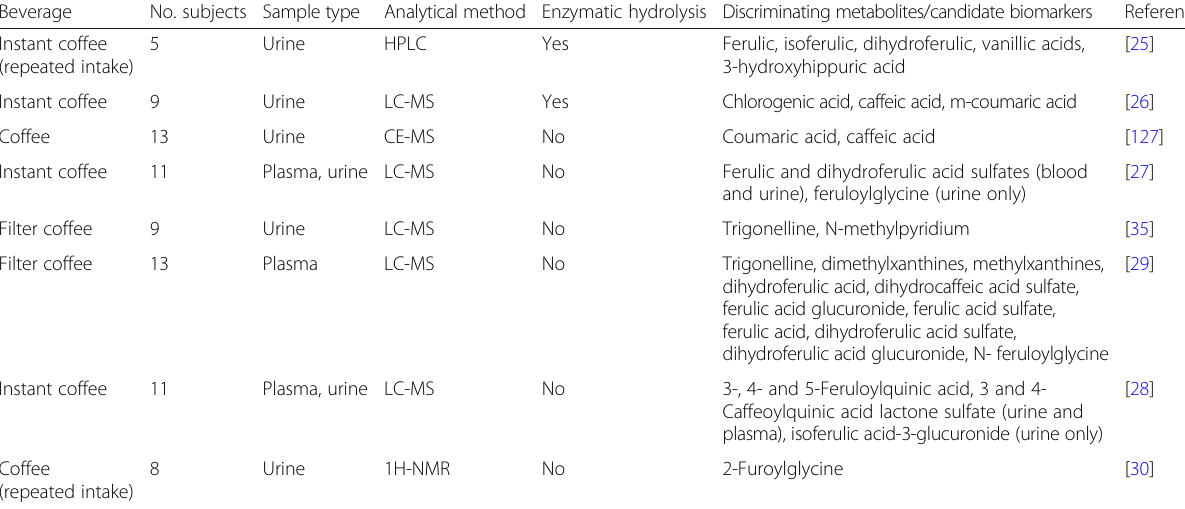
Table 1 Metabolites identified in human intervention studies on coffee